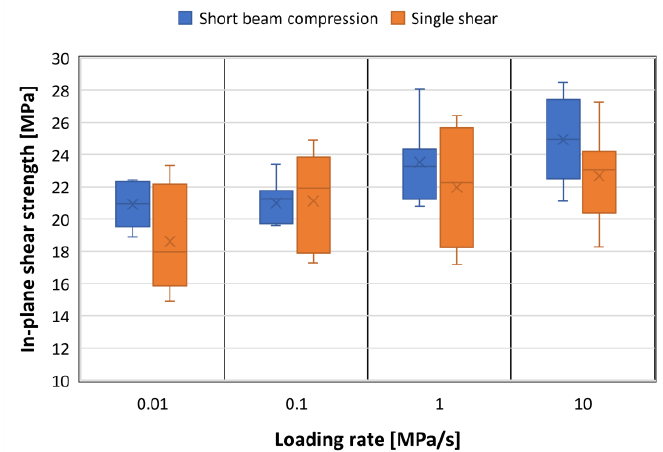
Figure 11. Comparison of the in-plane shear strength between the short-beam compression and single-shear tests.